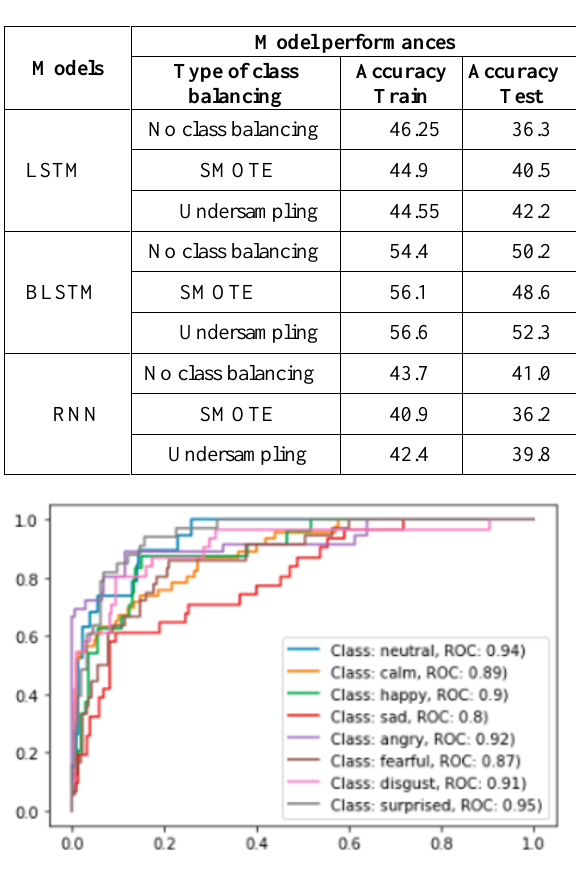
Table 1. Comparison of different neural network